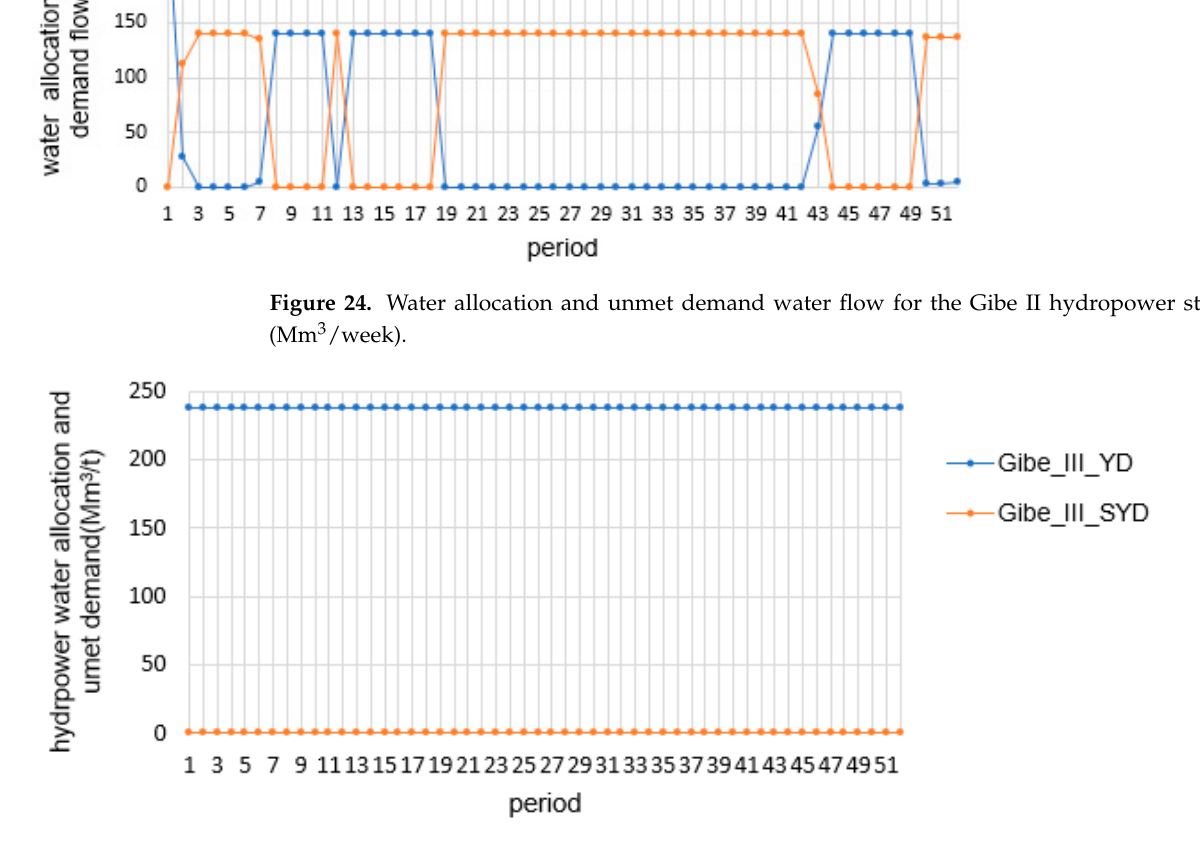
Figure 25. Water allocation and unmet demand water flow for the Gibe III hydropower station. (Mm 3 /week).